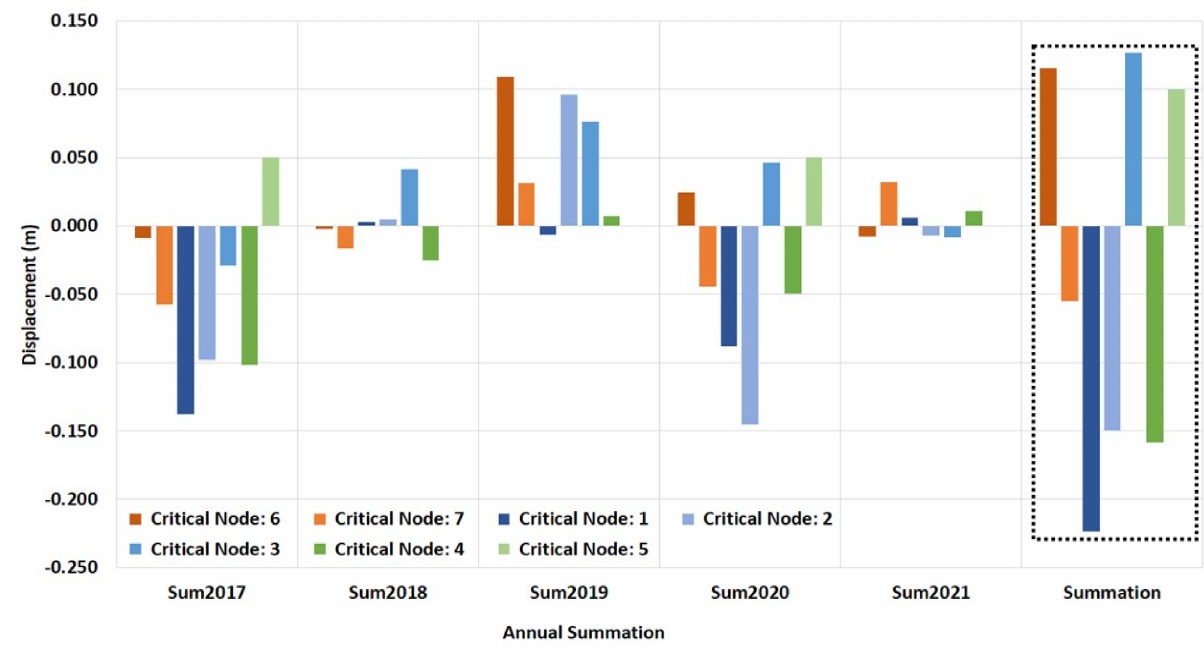
Figure 11. Vertical displacement analysis over the seven critical nodes identified at the Saddle Dam for the period from 2017 till